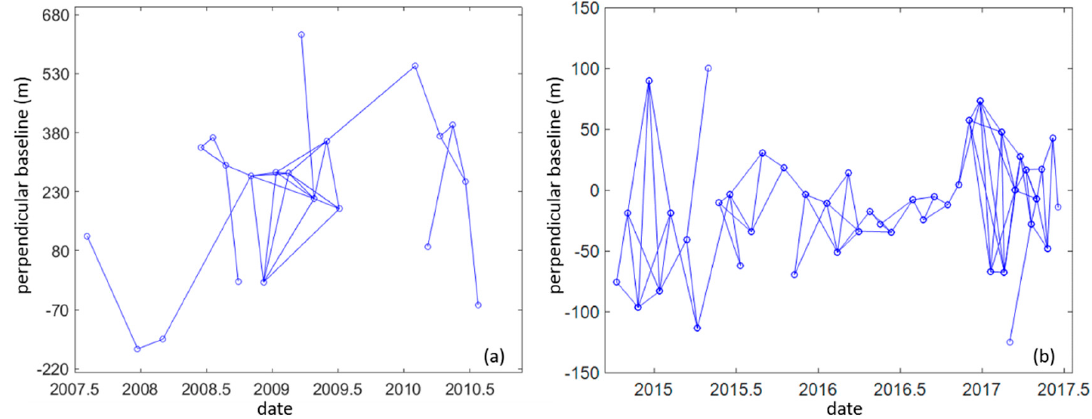
Figure 2. The configurations of the temporal and spatial baselines of interferograms: ( a ) Envisat data, ( b ) Sentinel-1A/B data.